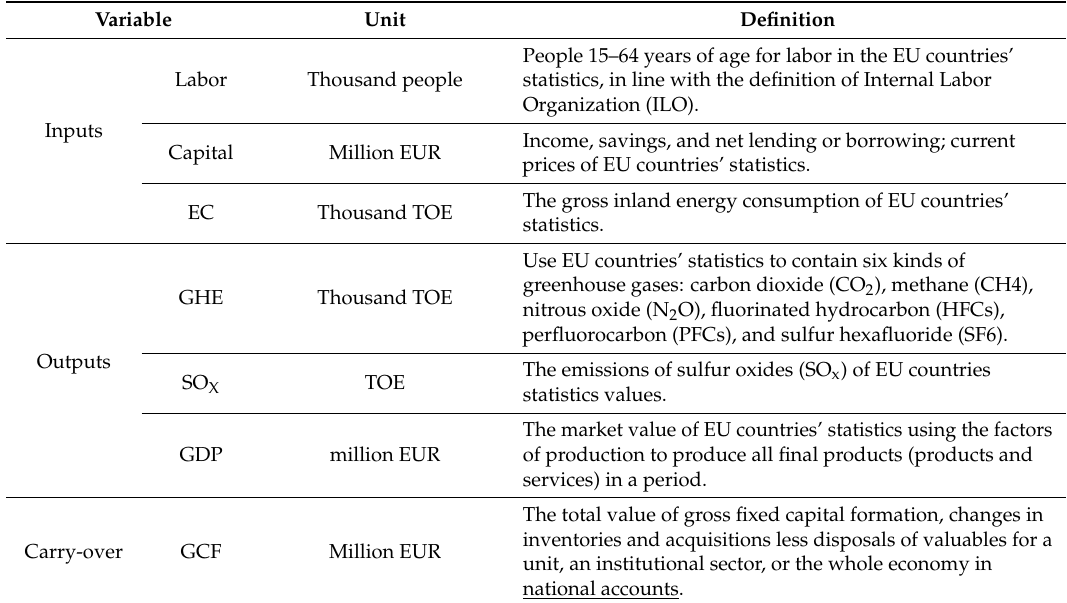
Table 2. Variables’